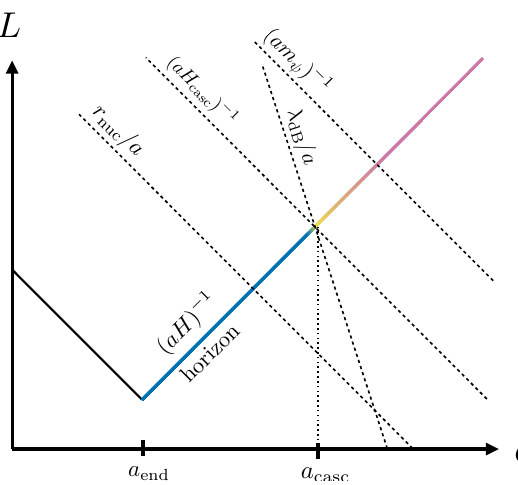
Figure 12. The important lengthscales to consider for SFQED processes in the background pri- mordial electric field from inflation. We construct the diagram by observing that, for | ~E 0 | > E 0 r nuc < λ C = m − 1 and r nuc = λ dB when H = m ψ . H casc = ( e d E 0 ) 1 / 2 is the rate of expansion of the ψ universe that is slow enough that a QED cascade can build up. As long as r nuc and λ dB (cid:28) r nuc are both less then H − 1 (which is both the size of the universe and the coherence length of the stochas- tic background field), the approximation of a locally constant background field is appropriate and the production rates of SFQED in time-independent, homogeneous fields can be used. As a visual aid to comparison, the horizon after inflation has been color-coded according to the era defined on figure